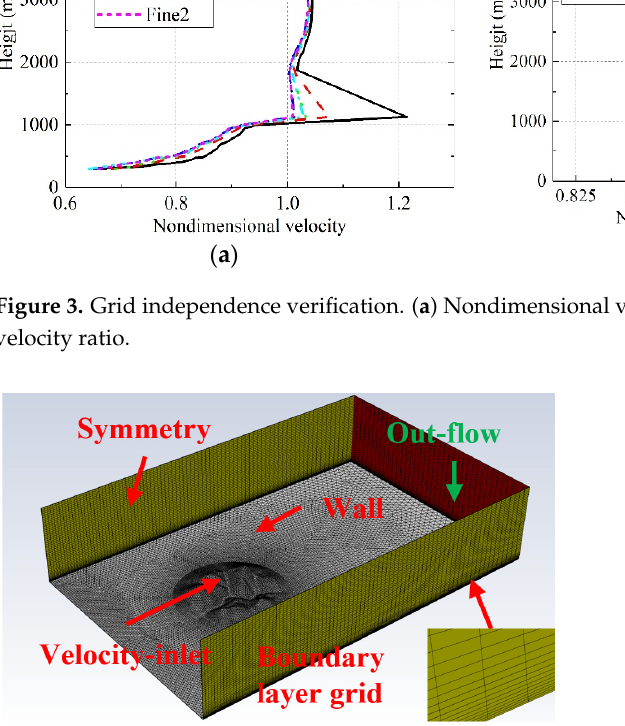
Figure 4. Schematic diagram of grid and boundary.